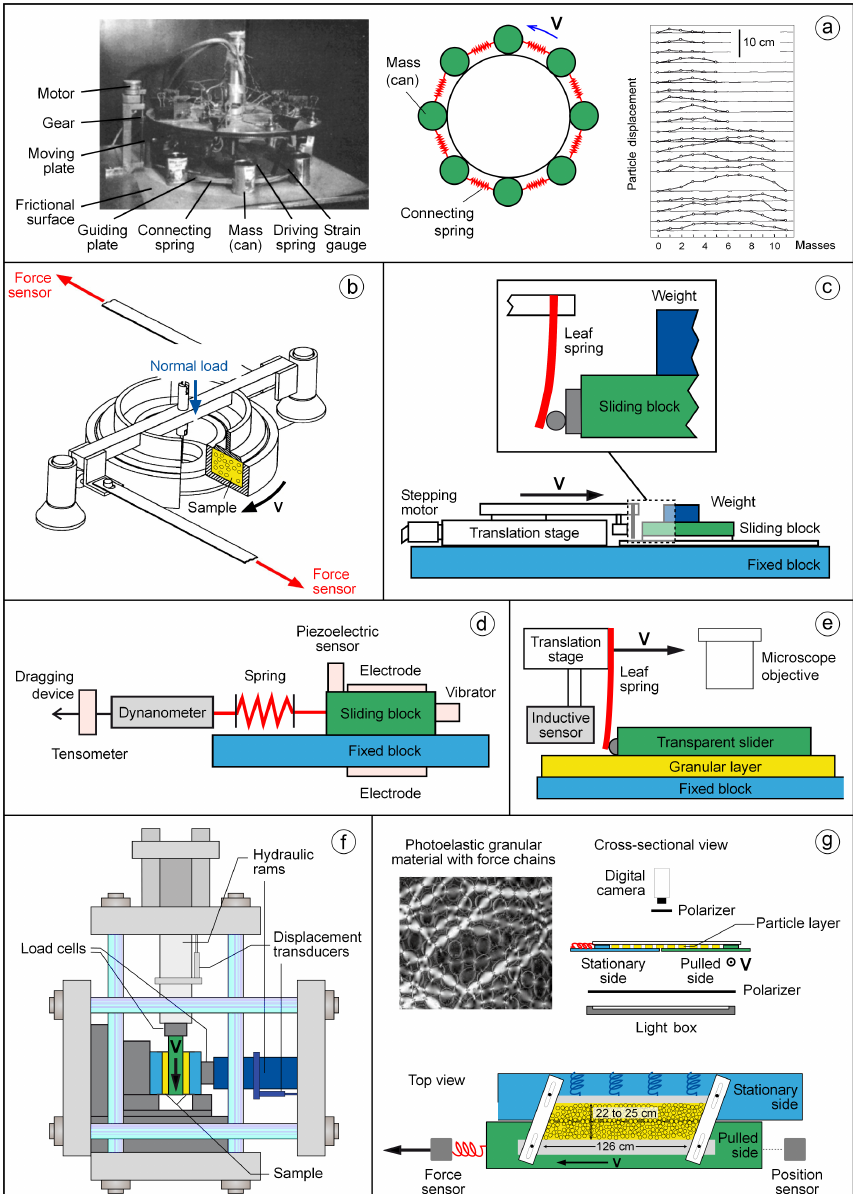
Figure 2. Examples of spring-slider models: (a) King’s circular-chain, multiple spring-slider set-up and example of rupture (modified after King 1975, 1991, 1994, reproduced and adapted with permission from Springer); (b) Schulze ring-shear tester used to characterize frictional properties of granular materials in this study (modified after Schulze, 1994); (c) spring-slider set-up after Heslot et al. (1994) (adapted with permission from Heslot et al. (1994), copyrighted by the American Physical Society); (d) spring-slider set-up used by Varamashvili et al. (2008) (modified from there); (e) set-up of see-through experiments by Nasuno et al. (1998) (adapted with permission from Nasuno et al. (1998), copyrighted by the American Physical Society); (f) double-direct shear configuration used to shear rods in various configurations by Knuth and Marone (2007) (modified from there); (g) simple shear set-up and visualization of force bridges in granular media by see- through experiments of Daniels and Hayman (2008) (modified from